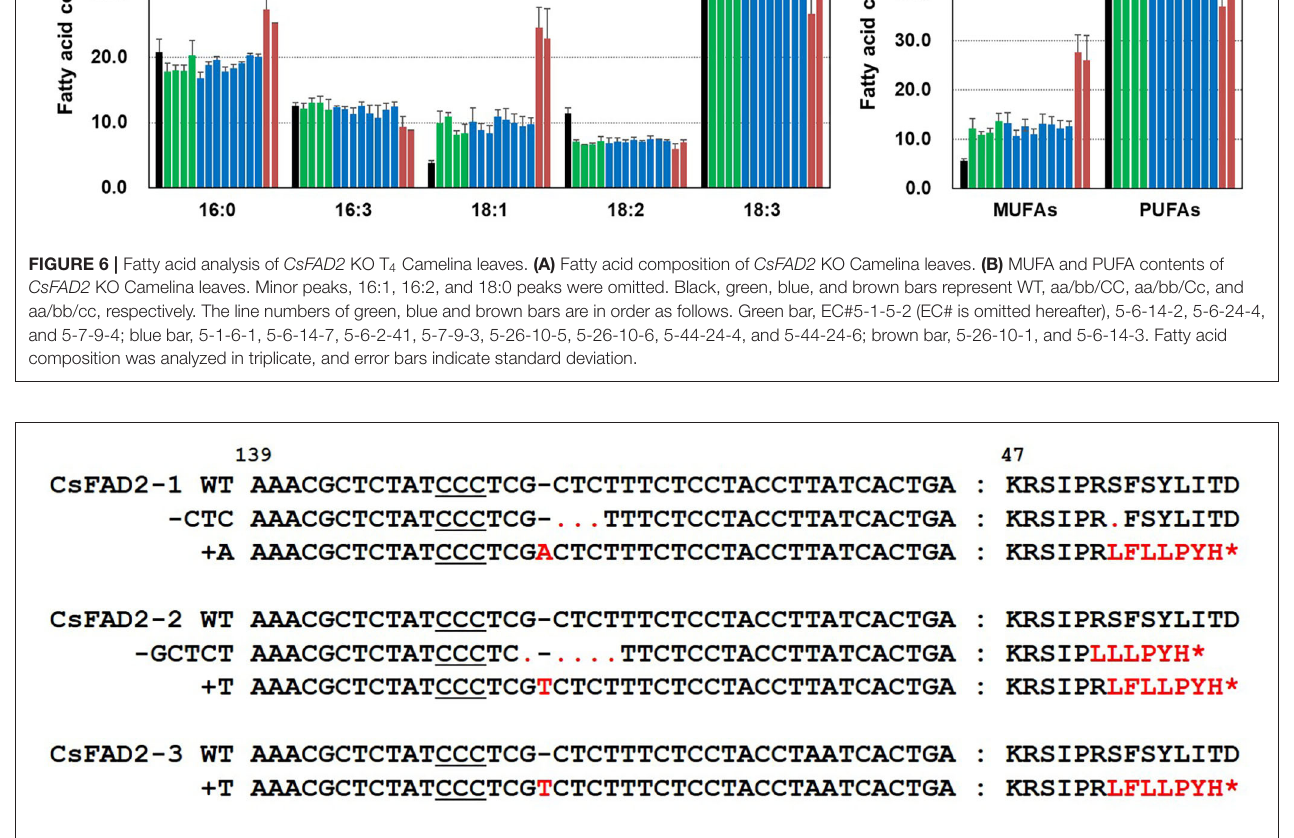
FIGURE 7 | Nucleotide sequences and deduced amino acid sequences of mutants from three CsFAD2 homoeologs. Red font indicates different nucleotides or amino acids compared to WT. Dots and asterisks represent gaps produced by deletion and the termination of translation, respectively. The PAM sequence used in this study is